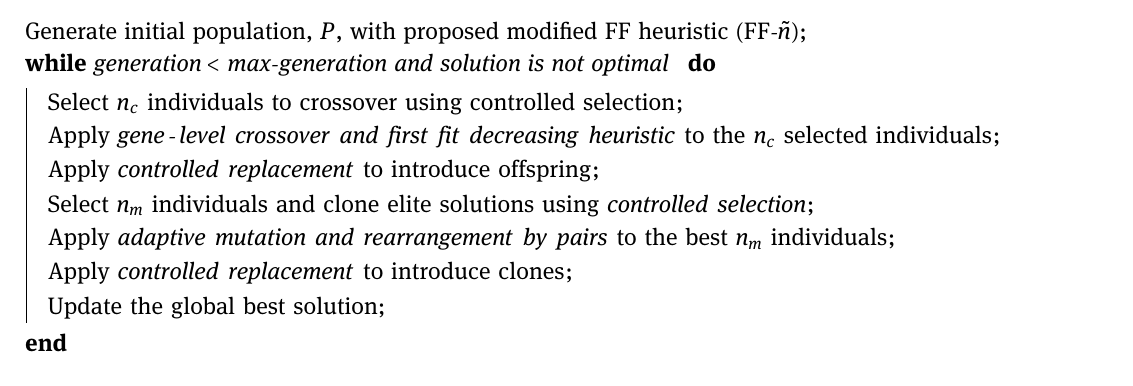
Algorithm 5 : Pseudocode of grouping genetic algorithm with controlled gene